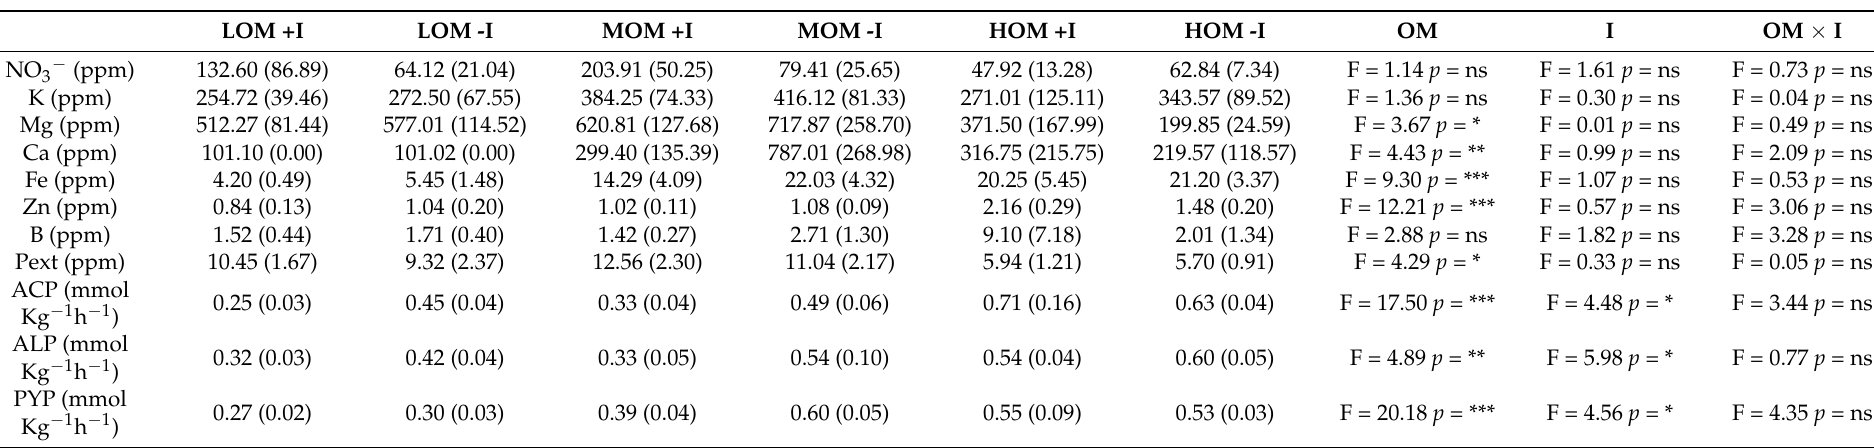
Table 1. Mean values ( ± SE) of the soil nutrient concentrations and enzymatic activity at various treatments. +I and -I refer to irrigation and non-irrigation; OM: organic matter; ACP: Acid phosphatase; ALP: Alkaline phosphatase; PYP: pyrophosphatase. (ANOVA, ns: non-significant; *: p ≤ 0.05; **: p ≤ 0.01; ***: p ≤ 0.001). LOM +I LOM -I MOM